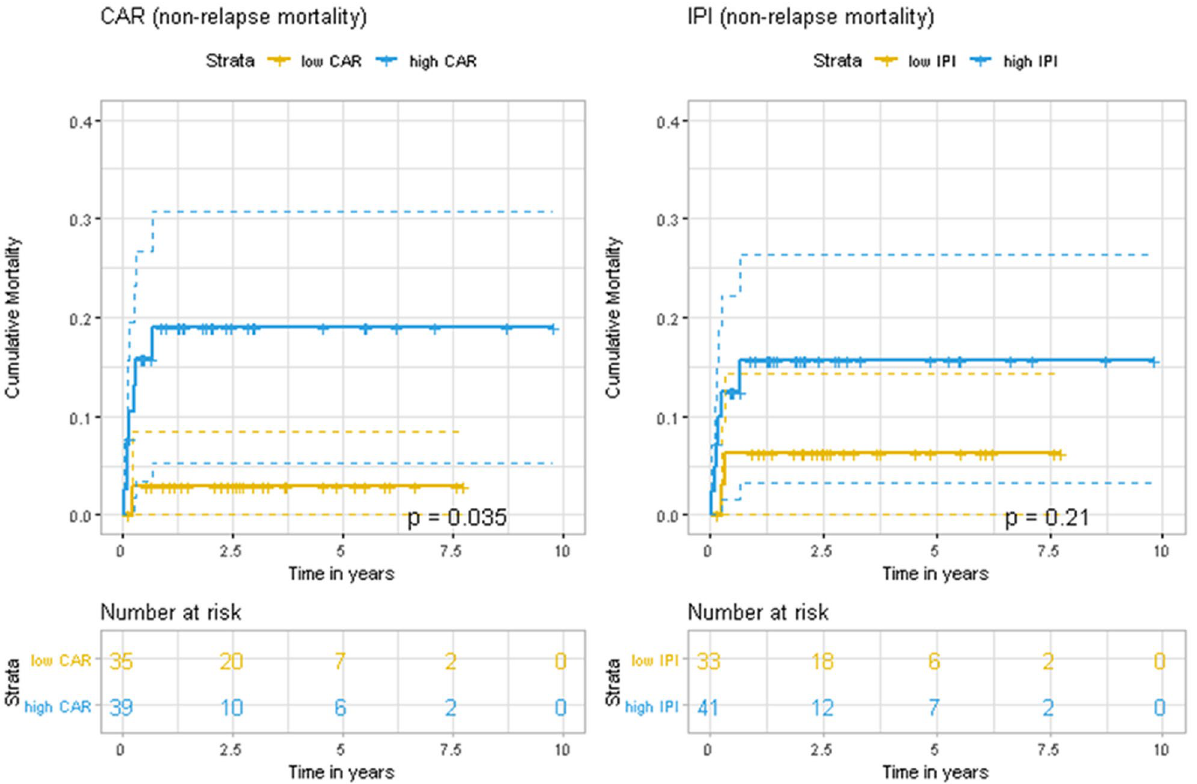
Figure 5. Kaplan–Meier curves for non-relapse mortality according to the C-reactive protein-to-albumin ratio (CAR) and International Prognostic Index (IPI) among patients who were > 60 years old at the diagnosis of diffuse large B-cell